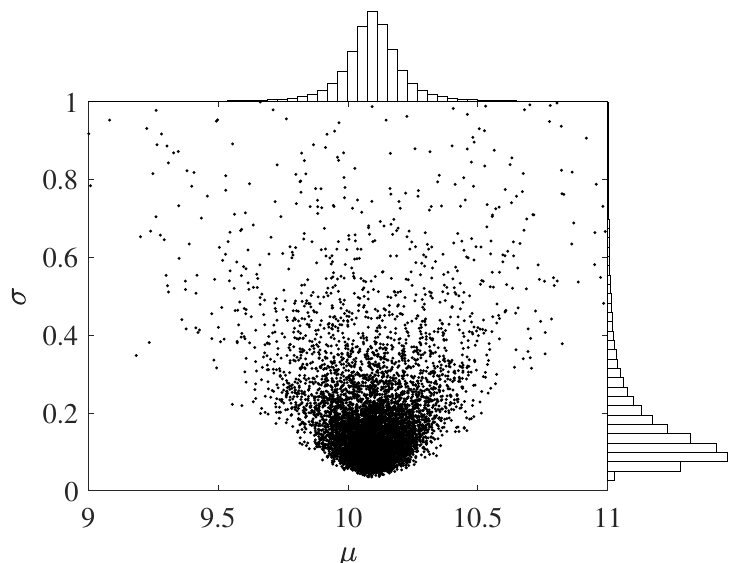
Figure 3. Samples drawn from the posterior PDF and histograms.